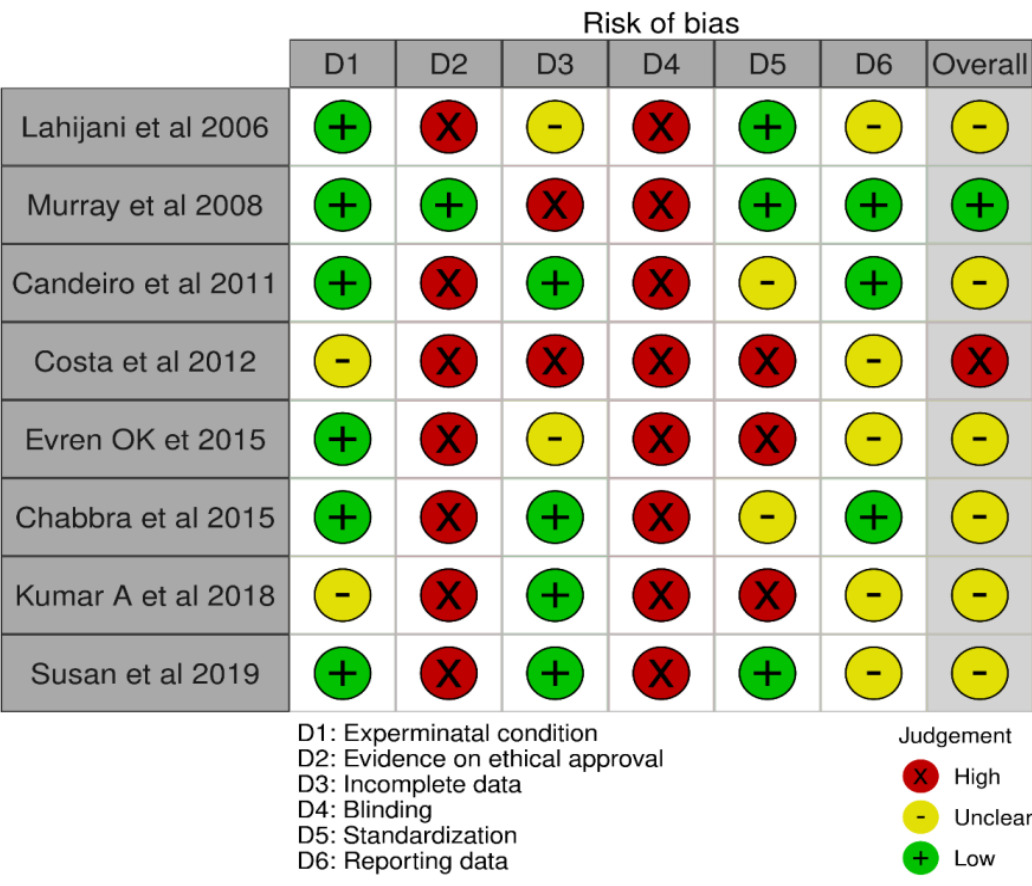
Figure 2. Risk of bias.